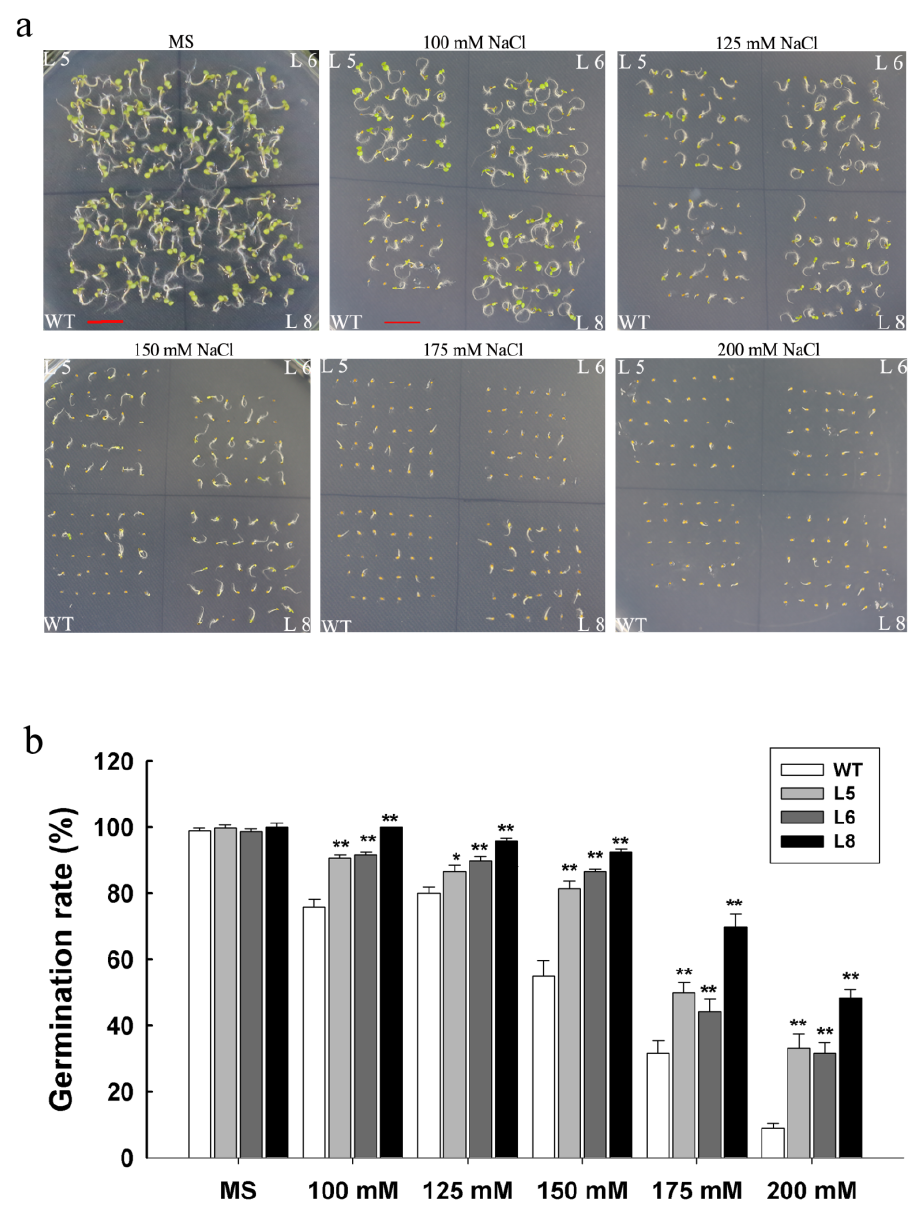
Figure 4. Salt stress tolerance of LcSAIN3 transgenic Arabidopsis plants at germination stage. ( a ) Phenotypes of WT (wild-type) and LcSAIN3- overexpressing lines (L5, L6, and L8 seeds) in MS medium with 0, 100, 125, 150 175, or 200 mM NaCl. ( b ) Seed germination rate under salt stress. Thirty seeds were allowed to grow for seven days after sowing, and each column represents an average of three replicates, and the bars indicate standard deviations (SDs). ** and * indicates significant differences in comparison with the control at p < 0.01 and p < 0.05. Scale bar = 1 cm.